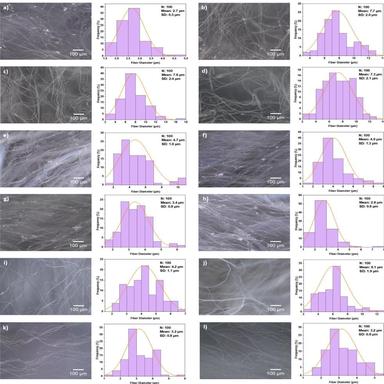
Wet sampling optical micrographs of PCL:PEO binary polymer systems soaked in 0.3 mL deionized water for 15–60 min. Binary PCL:PEO ratios: a) 14:1 15 min, b) 14:1 30 min, c) 14:1 45 min, d) 14:1 60 min, e) 4:1 15 min, f) 4:1 30 min, g) 4:1 45 min, h) 4:1 60 min, i) 2:1 15 min, j) 2:1 30 min, k) 2:1 45 min, l) 2:1 60 min, m) 8:7 15 min, n) 8:7 30 min, o) 8:7 45 min, p) 8:7 60 min, q) 2:3 15 min, r) 2:3 30 min, s) 2:3 45 min, t) 2:3 60 min, u) 1:4 15 min, v) 1:4 30 min, w) 1:4 45 min, and x) 1:4 60 min, respec